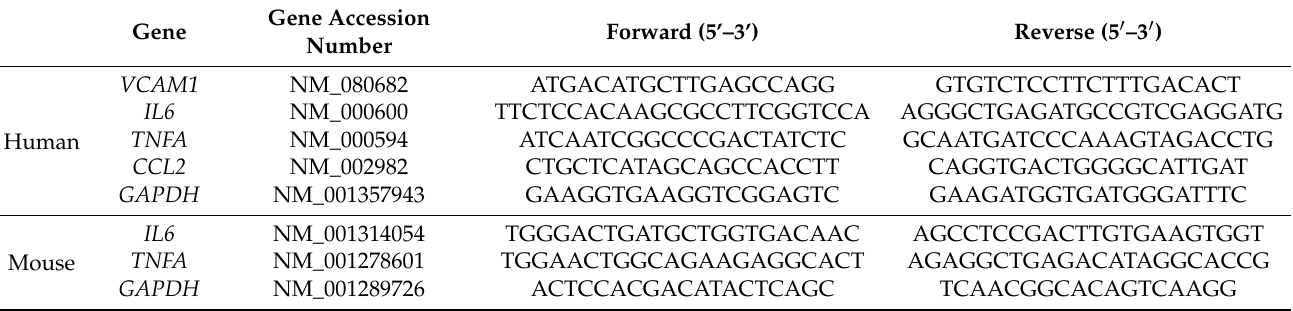
Table 1. List of gene-specific primer